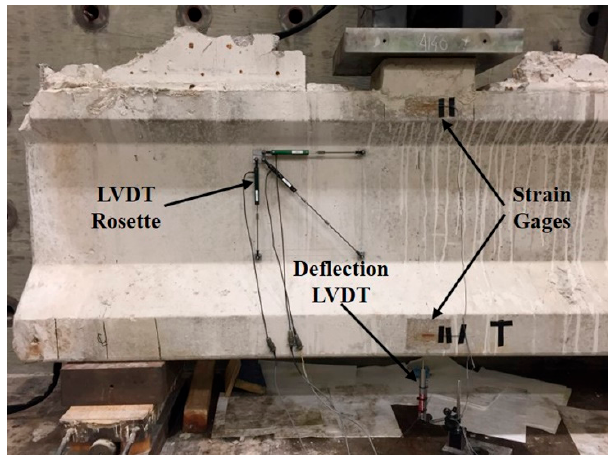
Figure 4. Three-point bending testing instrumentation (1:27).